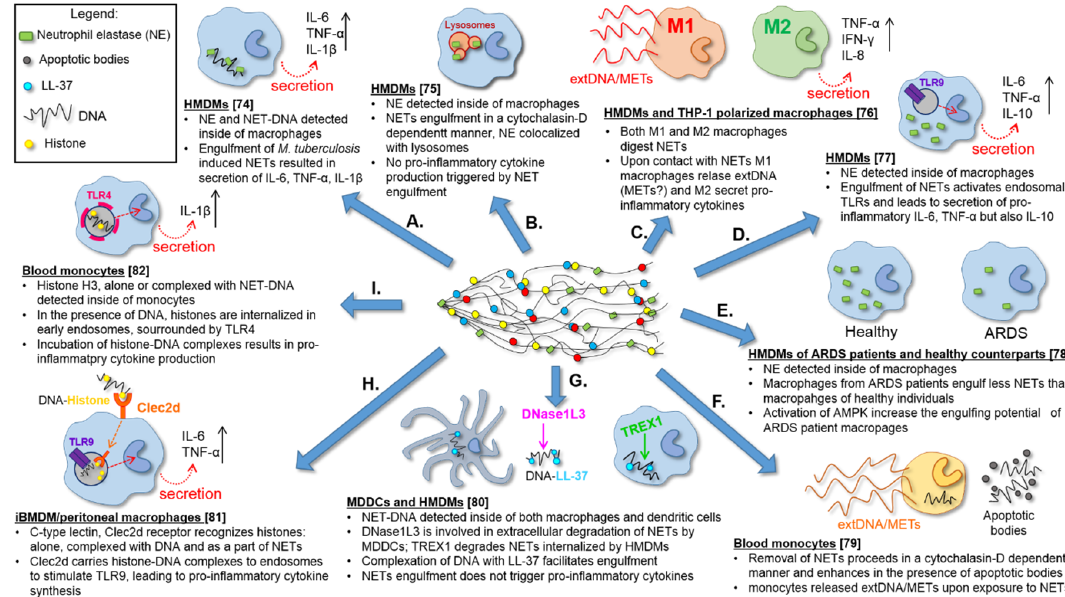
Figure 3. Conclusions from studies on NET removal published so far (July 2020). Neutrophil extracellular traps were shown to be removed by HMDMs, MDDCs, THP-1, iBMDM, peritoneal macrophages and blood monocytes as their remnants were detectable inside the removing cells e.g., inside the lysosomes (arrow ( B )). In some cases (arrows ( A , C , D )) engulfment of NETs induced production of pro-inflammatory cytokines, whereas in others, contact with NETs resulted in extDNA / METs release (arrows ( C , F )) by macrophages and monocytes. Ability to remove NETs was lower in HMDMs of ARDS patients (arrow ( E )), but the presence of apoptotic bodies (arrow ( F )), or complexation of DNA with LL-37 (arrow ( G )) facilitated the process of NET removal. Moreover, the cell specific involvement of various NET-degrading enzymes—DNases, was established, with DNase1L3 (DNase γ ) being specific to MDCCs and TREX1 (DNase III) being characteristic to HMDMs. Recently, two receptors—Clec2d (arrow ( H )) and TLR4 (arrow ( I ))—were shown to recognize histones of